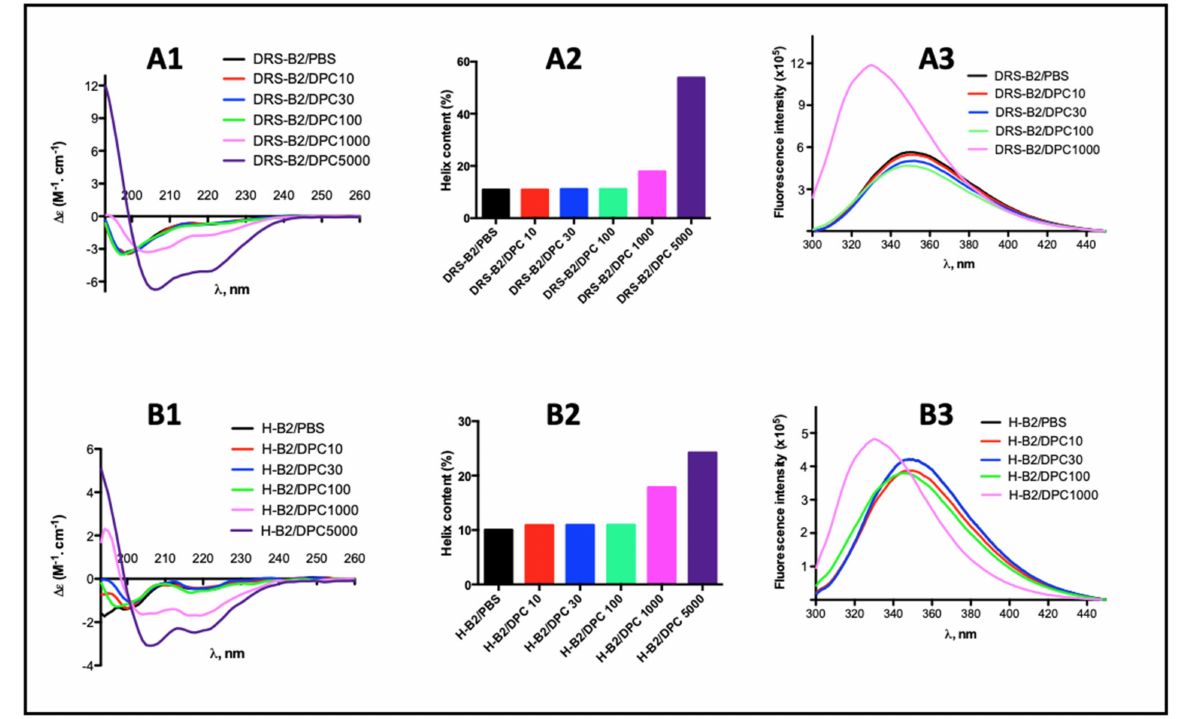
Figure 6. Circular dichroism and fluorescence spectra of DRS-B2 ( A1 , A3 ) and H-B2 ( B1 , B3 ) alone in PBS or in the presence of increasing concentration of DPC. ( A2 , B2 ) represent the percent of helix content in DRS-B2 and H-B2, alone or in presence of an increasing concentration of DPC,